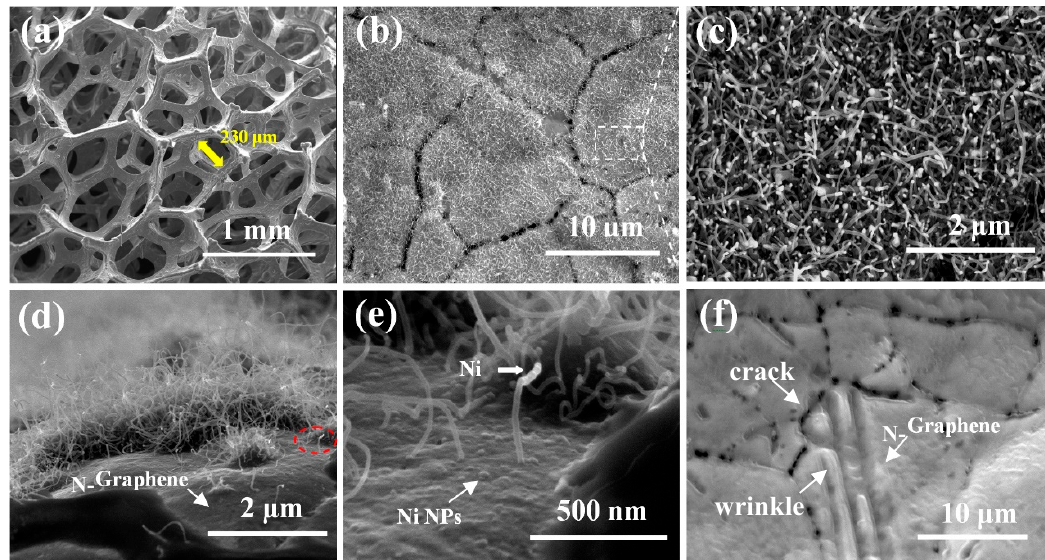
Figure 2. ( a ) SEM image of the N-CNTs/N-graphene hybrid grown on the surface of nickel foam; ( b , c ) The top view of low and high magnification SEM images of the N-CNTs; ( d , e ) Low-magnification and high-magnification SEM images of one side view of N-CNTs and N-graphene on the surface of the nickel foam; ( f ) SEM image of the only N-graphene layers grown on the surface of nickel foam.